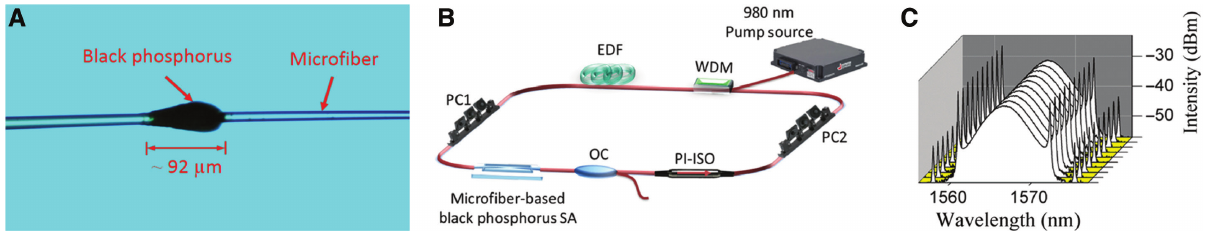
Figure 5: Er-doped mode-locked fiber laser with a BP-decorated microfiber SA. (A) Microscopic image of the fabricated microfiber-based BP SA. (B) Experimental setup. (C) Repeatedly recorded mode-locked spectrum at a 1-h interval. Reproduced with permission [203]. Copyright 2015, The Optical